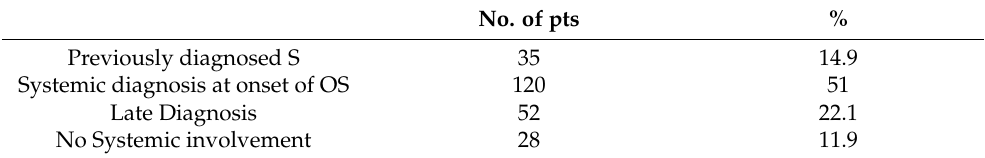
Table 4. Characteristics of systemic involvement in